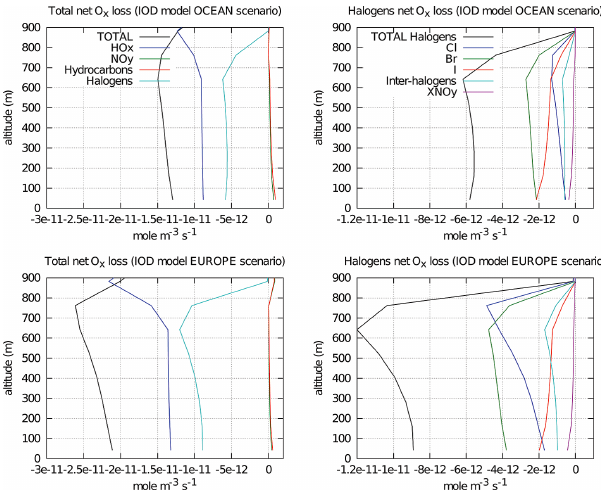
Figure 33. Vertical profiles at midday of total and halogen-induced net O x loss in an unpolluted (OCEAN scenario) and semi-polluted (EUROPE scenario) marine boundary layer (Sommariva and von Glasow,